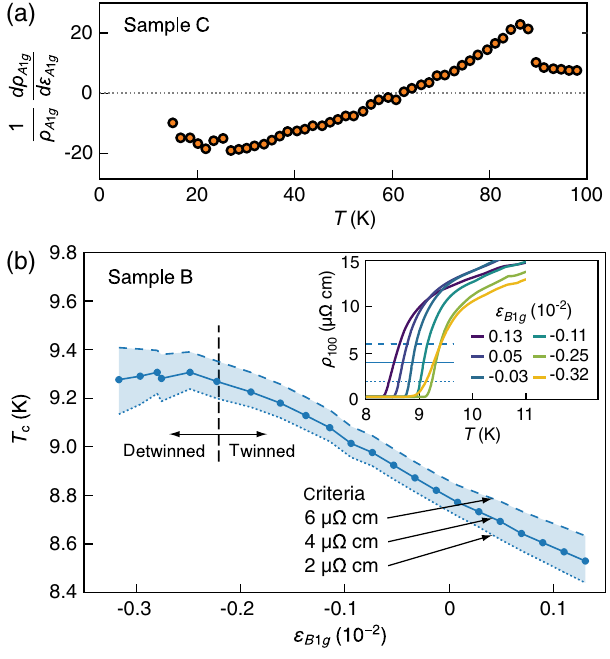
FIG. 7. Effect of biaxial strain. (a) A 1 elastoresistivity g ð 1 = ρ Þ d ρ =d ε versus T of sample C, determined as A 1 g A 1 g A 1 g explained in the text. (b) T versus strain, determined as the c temperature where the resistivity crosses specific values, as shown in the inset. Note that within the twinned region, ε B 1 g does not couple locally to the sample, and instead the effect on T is through the applied A 1 component of the strain. When c g ¼ 0 . 52 ε the platform deformation is elastic, this is ε . The A 1 g B 1 g ¼ − 450 =d ε observed slope therefore corresponds to dT c A 1 g